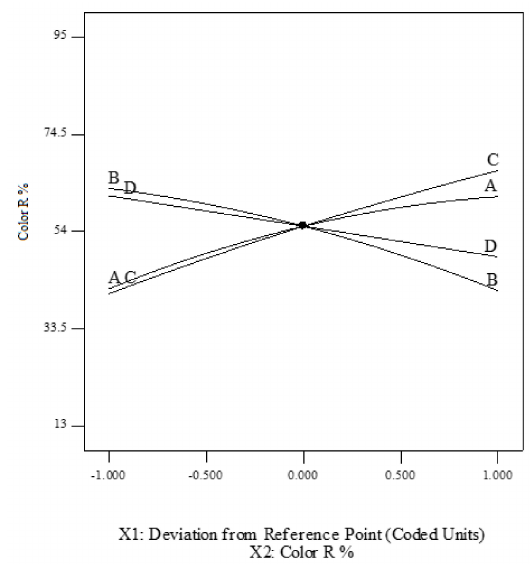
Figure 4. Perturbation plot for color removal.